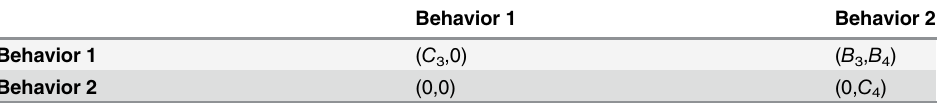
Table 2. The Payoff Matrix of the Interactions between Small Groups 1 and 2(Simplified